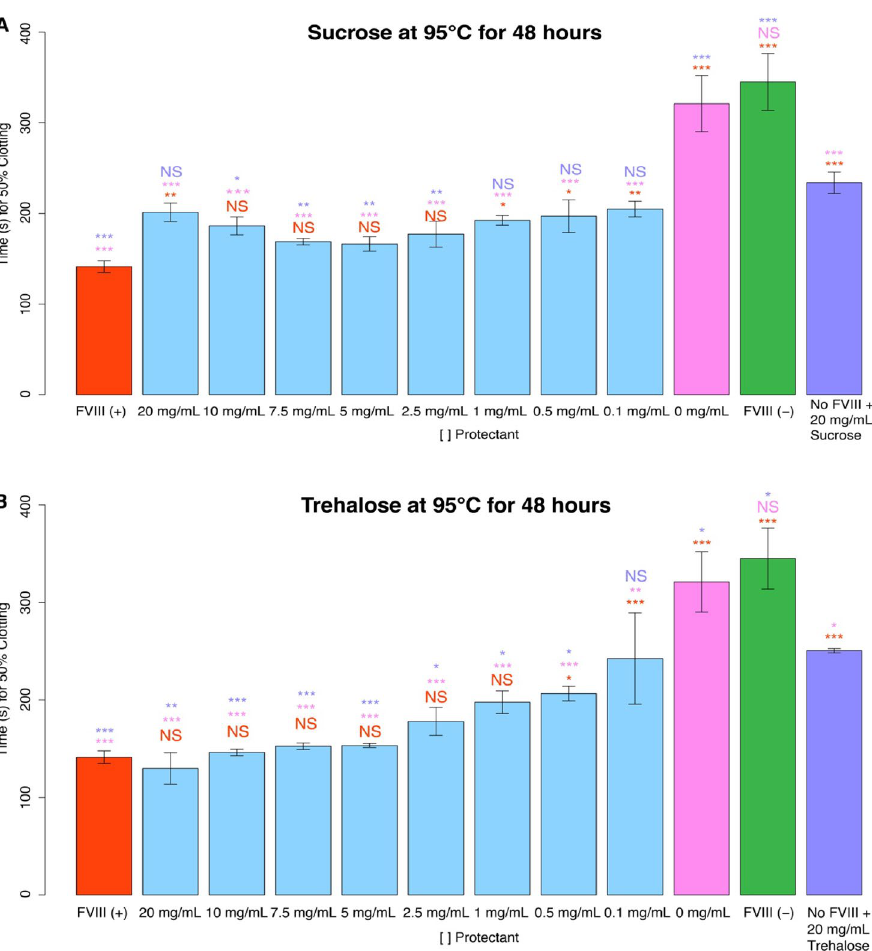
Figure 5. Using non-reducing disaccharides as potential stabilizers of FVIII under thermal stress. Histogram of the 50% clotting time of FVIII coincubated with ( A ) sucrose or ( B ) trehalose. The red “FVIII (+)” bar represents FVIII deficient human blood plasma treated with unstressed FVIII. All red notations above sample bars represent statistical comparison with “FVIII (+).” “X mg/mL” notations beneath sample bars correspond to the concentrations of non-reducing disaccharide mixed with FVIII before desiccation. All pink notations above sample bars represent statistical comparison with “0 mg/mL.” The green “FVIII (−)” bar represents FVIII deficient human blood plasma without FVIII supplementation. “No FVIII + X mg/mL Sugar ’’ represents FVIII deficient human blood plasma treated with X mg/mL non-reducing disaccharide, but no FVIII. All purple notations above sample bars represent statistical comparison with the “No FVIII + X mg/mL Sugar” sample bar. Notations above sample bars represent statistical significance determined by one-way ANOVA and Tukey’s post- hoc test. Error bars represent bi-directional standard deviation. P value > 0.05 = NS, P < 0.05 = *, P < 0.01 = **, P < 0.001 =